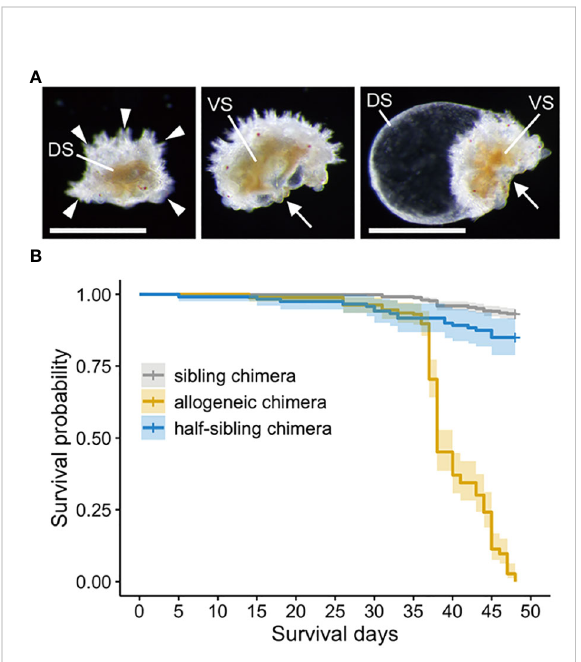
FIGURE 5 Abnormal morphologies and survival time analysis of allogeneic chimera juveniles. (A) Allogeneic chimera showing abnormal morphologies. Left: view of back bridge form from above. Middle: bent in half. Right: swelling like balloons. DS, dorsal side; VS, ventral side; Arrowheads: fi ve arms. Arrows: mouth. Scale bar: 500 µm. (B) Survival time curve of the juvenile stage using the Kaplan – Meier